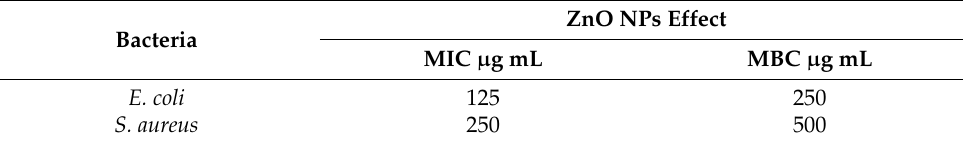
Table 2. Measured of MIC and MBC for ZnO NPS.